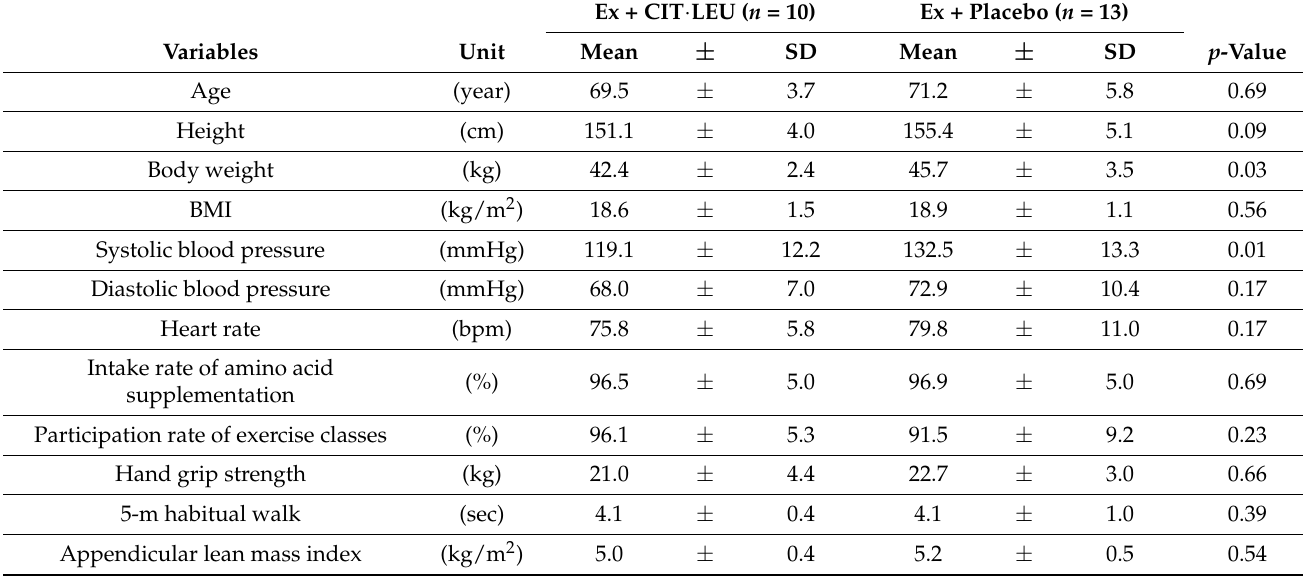
Table 1. Characteristics of the participants on